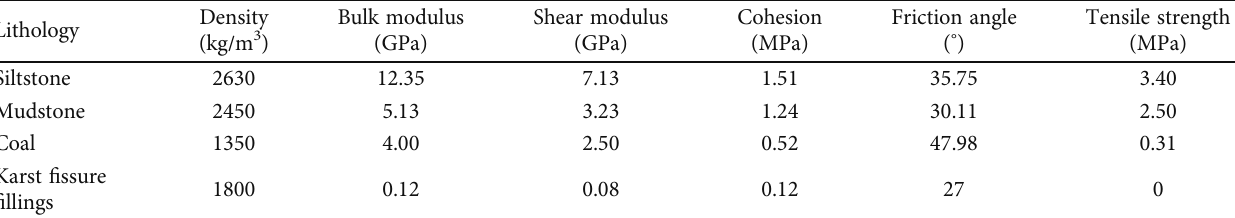
Table 2: Parameters of rock masses without the Voronoi